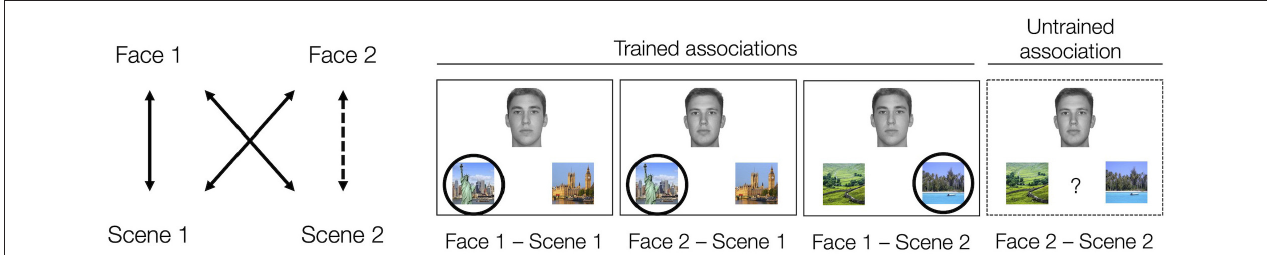
FIGURE 1 | Acquired equivalence task structure. Participants learn that two people (Face 1 and Face 2) share one association (in our task, living in the same city, e.g., New York not London) via feedback-based learning. They also learn an additional association for Face 1 (in our task, their preferred vacation location, e.g., the beach, not the countryside) also via feedback. The correct scene association for each face is indicated by a circle (Scene 1 and Scene 2). The other scene is a foil scene (Scene 1’ and Scene 2’). After training, participants are tested on these trained associations as well as on the untrained Face 2 – Scene 2 association (dashed line, dashed border). Participants were not informed of the structure of the task set nor that they would be tested on associations not present in the training phase. The tendency to say that Face 2 is associated with Scene 2 over Scene 2’ (e.g., the beach over the countryside) is taken as evidence of acquired equivalence between Face 1 and Face 2. All the faces depicted come from the Dallas Face Database (Minear and Park,